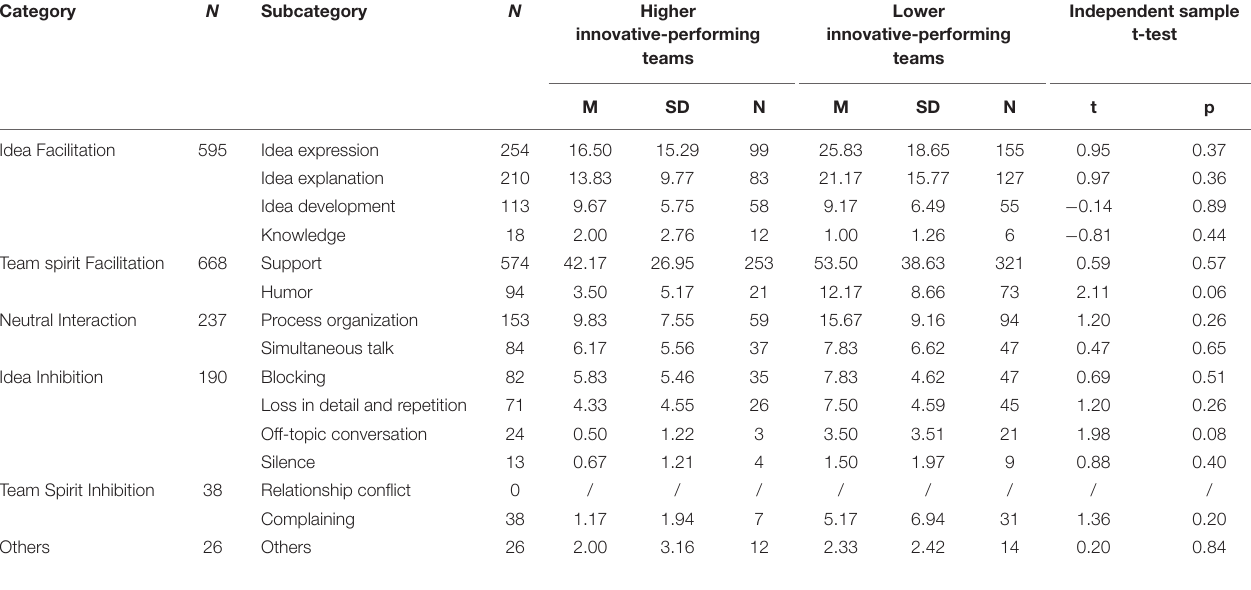
TABLE 2 | Descriptive statistics and t -test of coded behavior frequency for higher and lower innovative-performing teams. Category